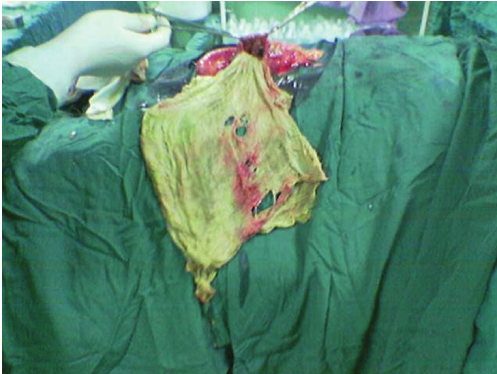
Figure 1: The gauze inside of the cyst, near omentum.